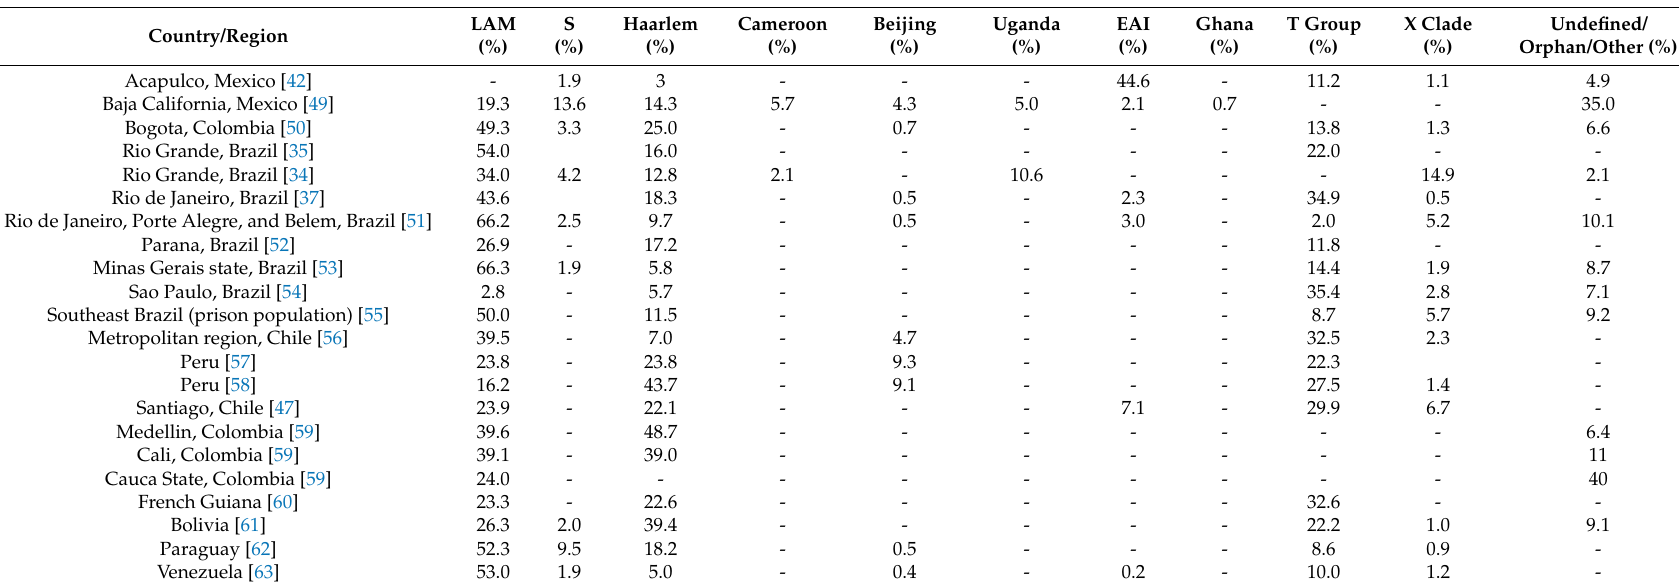
Table 1. The population diversity of Latin American MTB spoligotypes. The proportion of different spoligotypes in each country/region is expressed in percentages. Most studies did not report all spoligotypes found; their percentages therefore do not add up to 100%. Country/Region